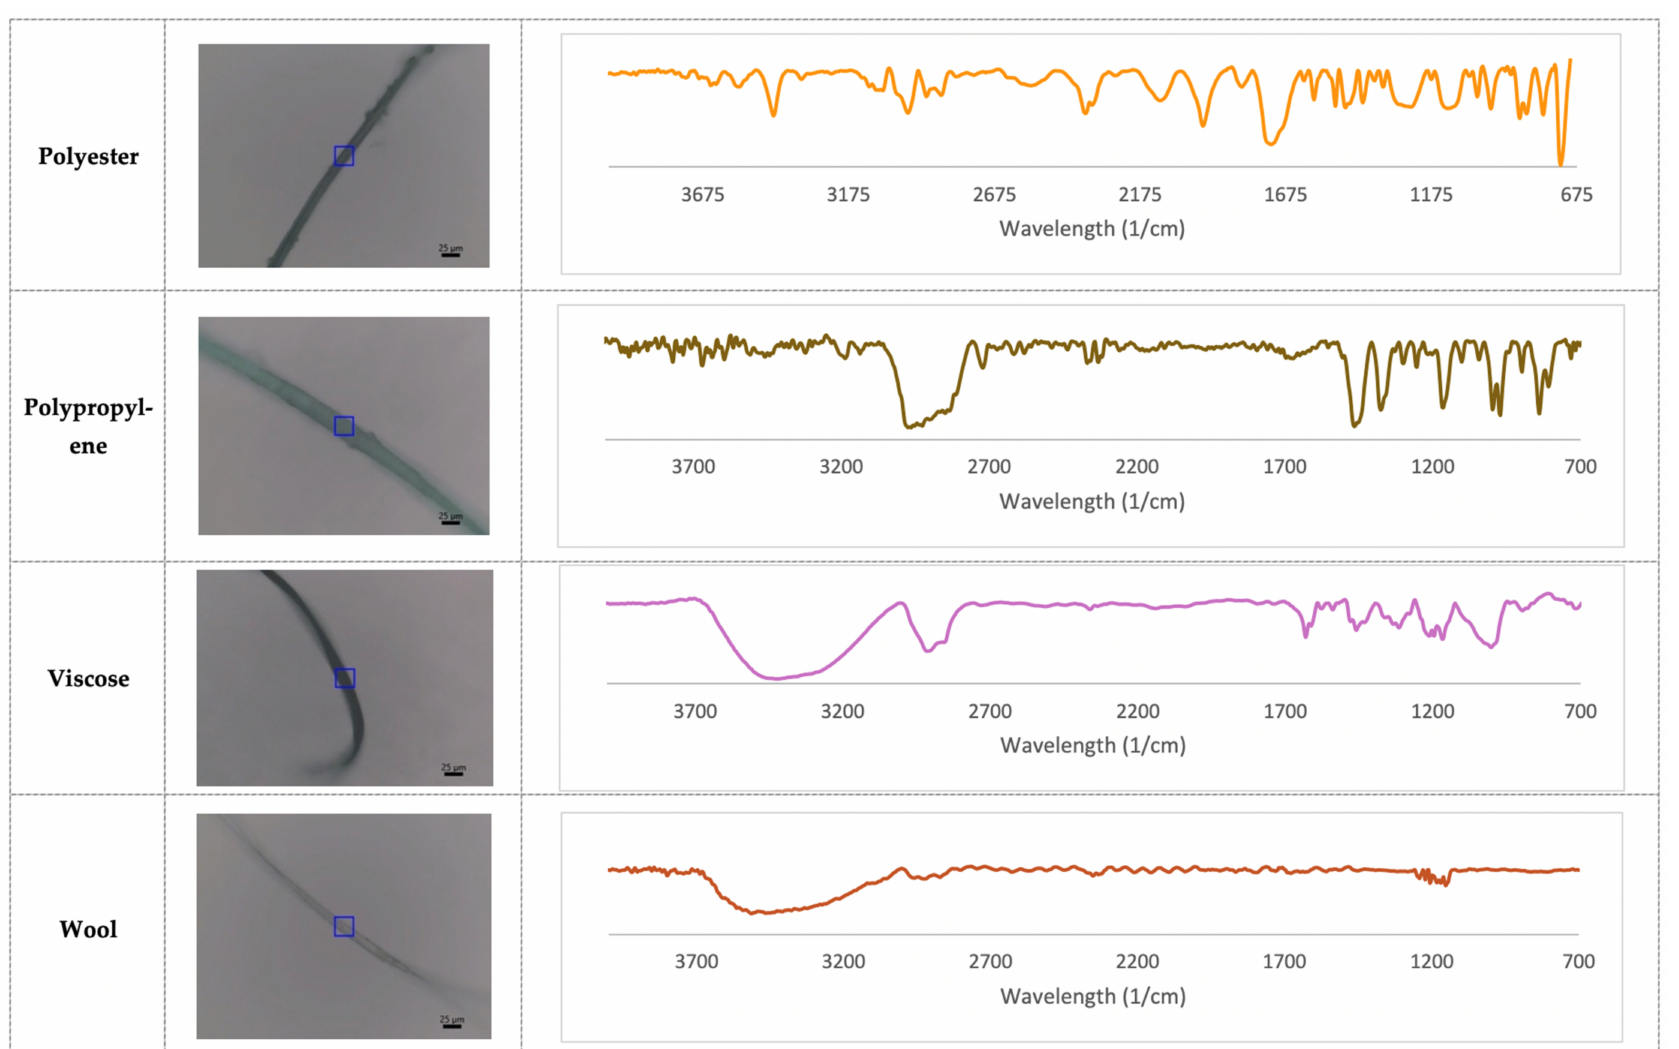
Figure 4. Results of the Micro-FTIR analyses on the recovered MFs and